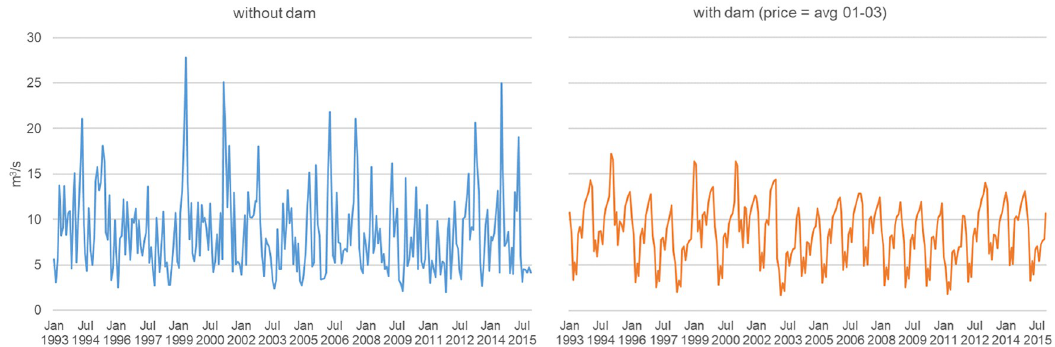
Fig 3. Natural flow pattern vs. standardized flow pattern. Average monthly flow volume for the period 1993 to 2015. The dam is operated according to market prices based on the average hourly prices of the German spot market from 2001 to 2003. A period during which the electricity market was dominated by fossil and nuclear energy leading to stable operational conditions.